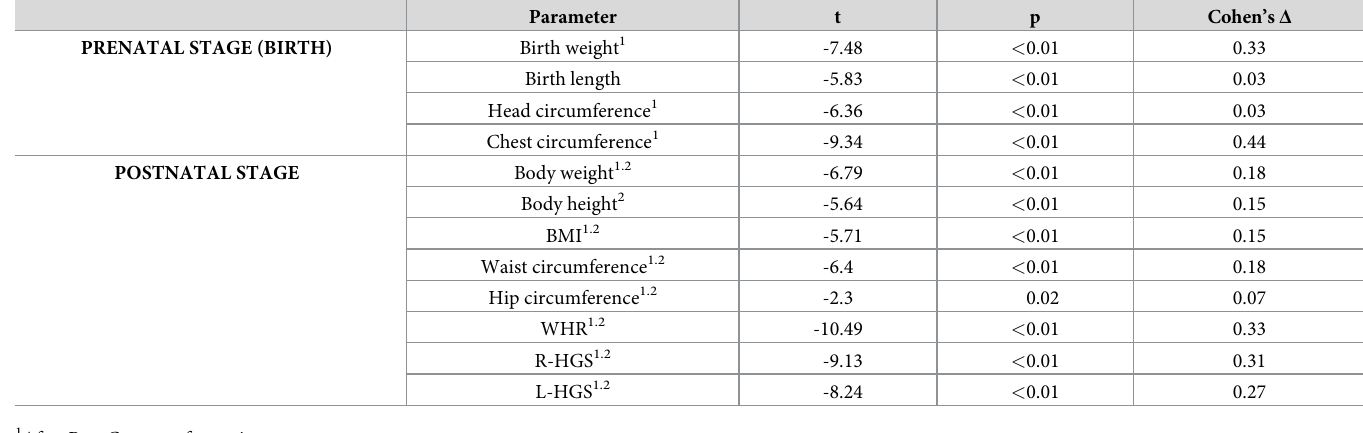
Table 2. Body size parameters and Cohen’s effect sizes.